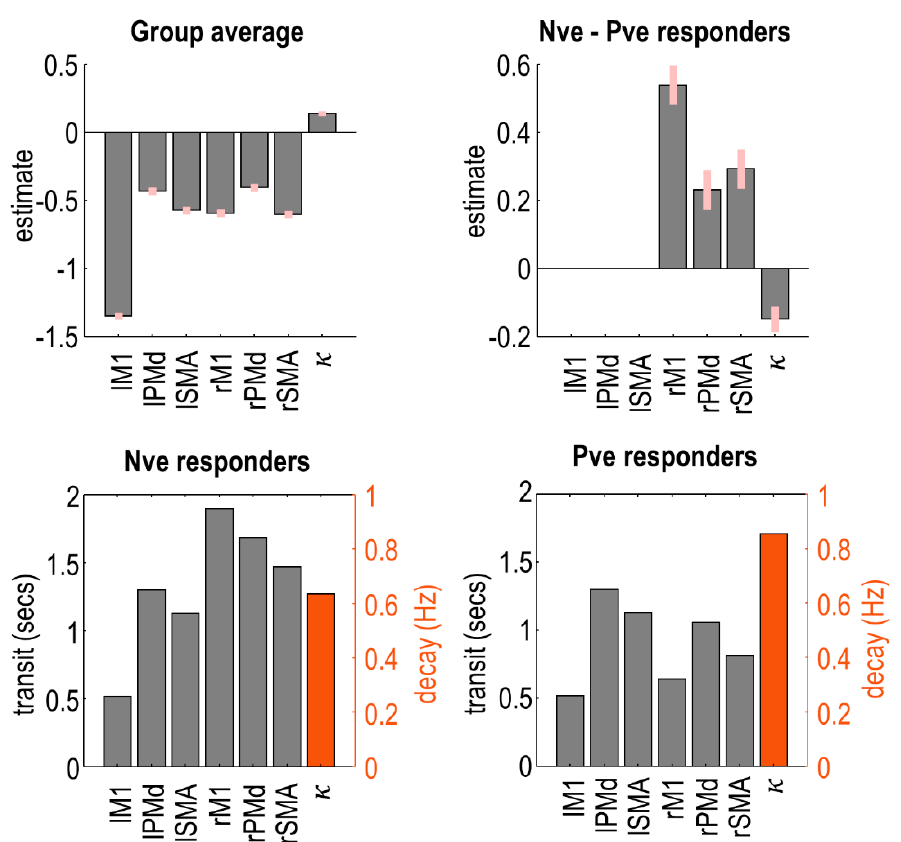
Figure 5. Haemodynamic parameters. ( Top row ) The posterior expected values and 90% credible intervals for the haemodynamic log-scaling parameters. In each plot, the first six bars are the transit parameters for each region, and the final bar is the decay parameter, which is pooled over regions. ( Bottom row ) The posterior expected values, transformed into the units of the underlying model (secs for transit, Hz for decay), plotted separately for each group of subjects.